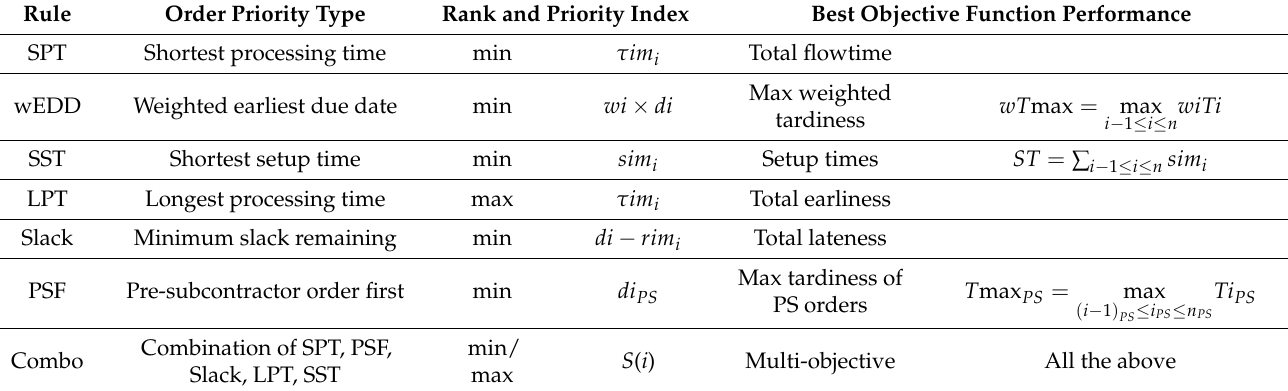
Table 5. PDRs embedded in the